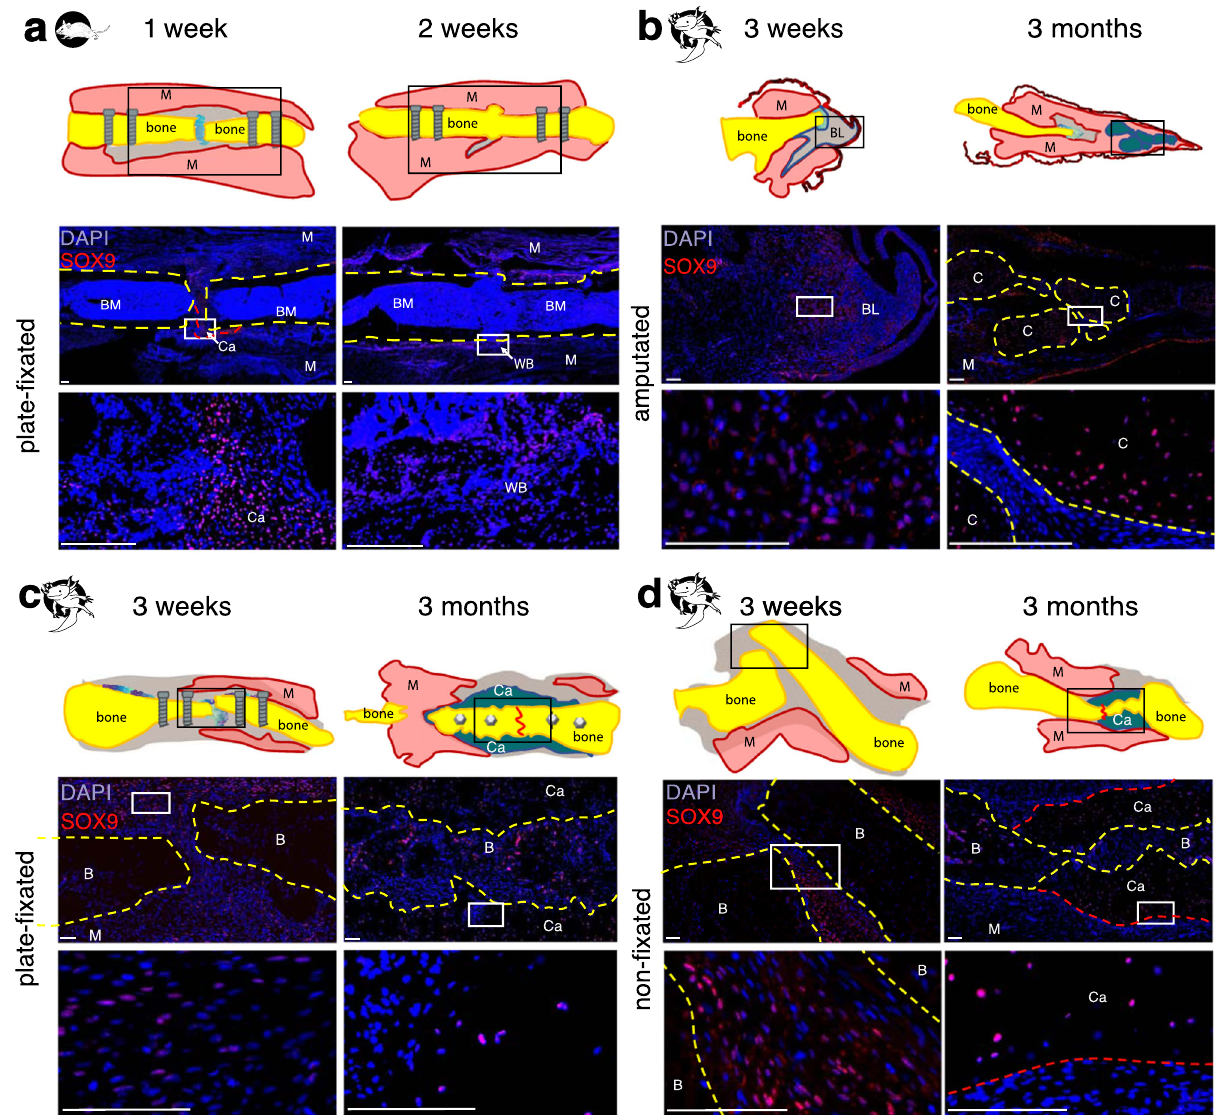
Fig. 4 Comparison of SOX9 expression in fractured bones and amputated limbs. a In axolotl amputated limbs, SOX9-positive cells are present in 3 weeks blastema and cartilaginous condensations in 3 months regenerate. b, c In axolotl fi xated and non-stabilized fractures, SOX9 expression is observed in pre-cartilage cells at 3 weeks post-fracture and in callus cells at 3 months post-fracture. d In murine fractures, SOX9- positive cells are present at 1 week post-fracture, and at 2 weeks, bone bridging by woven bone is in progress. Scale bars 200 µm. Yellow dashed line - bone, red dashed line - callus, BM – bone marrow, M – muscle, C – cartilage, Ca – callus, BL – blastema, B –